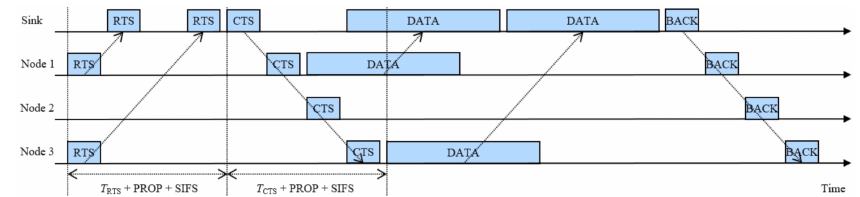
Figure 1. An example of the proposed underwater multi-DATA train protocol.